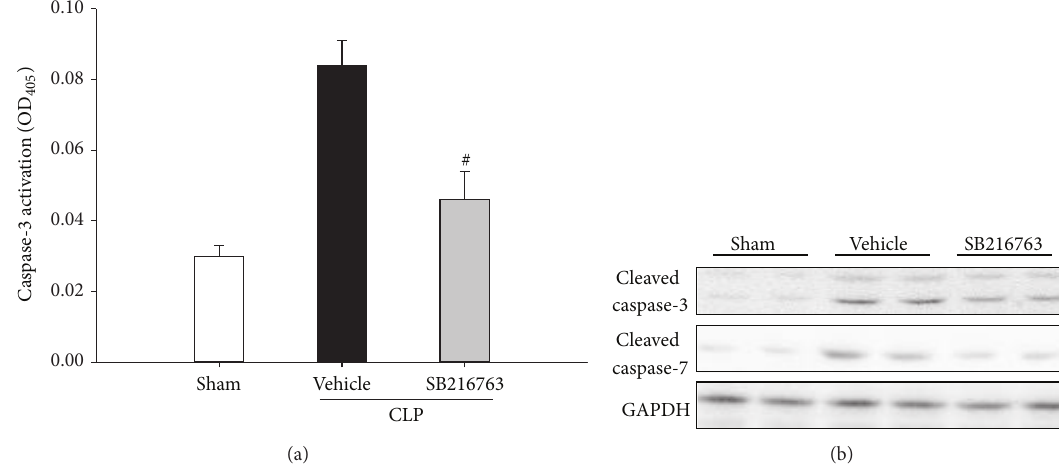
Figure 6: GSK-3 𝛽 inhibition prevents the CLP-induced hepatic apoptosis. (a) Mice were subjected to CLP and treated with either SB216763 (25 mg/kg, i.p.) or vehicle (DMSO). Liver samples were harvested at 20 h after CLP. The caspase-3 activity was measured. Data are shown as mean ± SD. 𝑛 = 6 per group. # 𝑃 < 0.01 compared with vehicle-treated group. (b) The expression levels of the cleaved caspase-3 and the cleaved caspase-7 were examined by western blotting